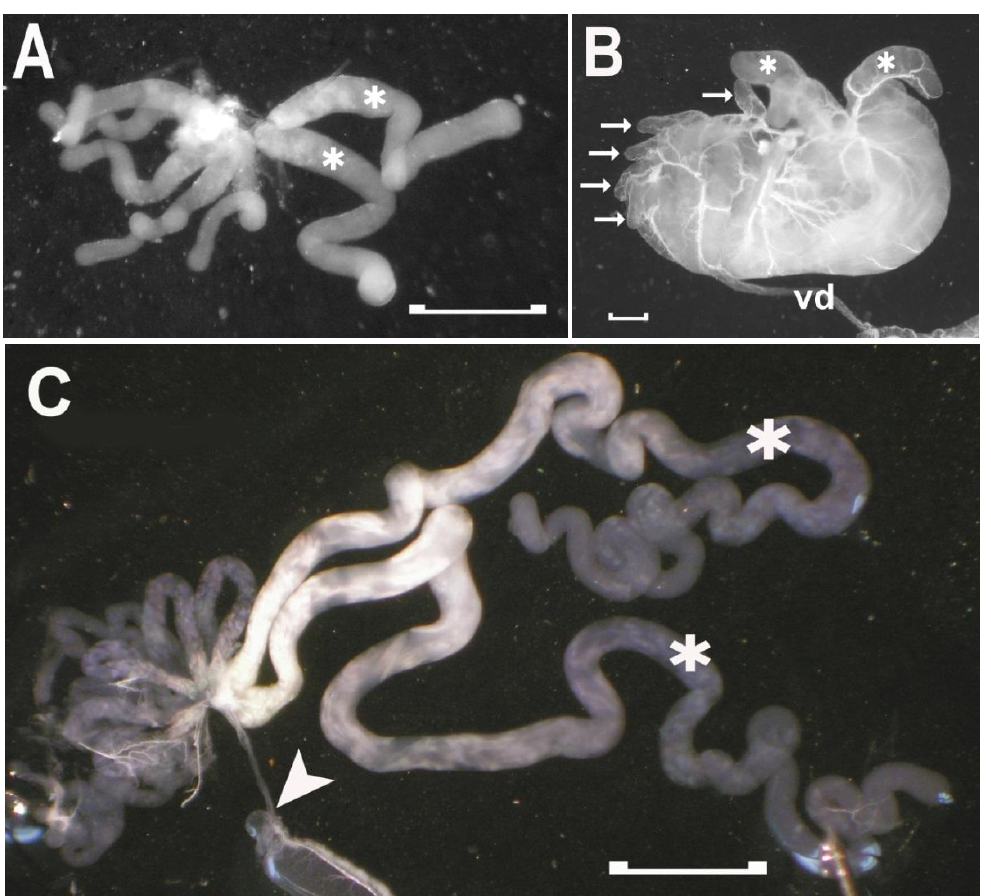
Figure 6. The testicular follicles and testis in R. prolixus taken from an L5 (A), a recently emerged adult (B), and a two-month old reproductively active adult (C). The five smaller follicles and two larger follicles (asterisks) are easily identified in the L5 (A). Even in an intact testis in B, the tips of the smaller follicles (arrows) can be distinguished from the two larger follicles. Testis growth with age is primarily due to growth of the two larger follicles. The larger follicles are approximately one and a half times longer than the smaller follicles in the young testis, but up to five to six times longer than the small follicles of the older testis (C). The vas deferens and the anterior transparent gland are not present in the L5, since these are adult structures that emerge in the process of metamorphosis. In C, the arrowhead denotes the attachment of the vas deferens to the transparent accessory gland. Scale bars: 0.2